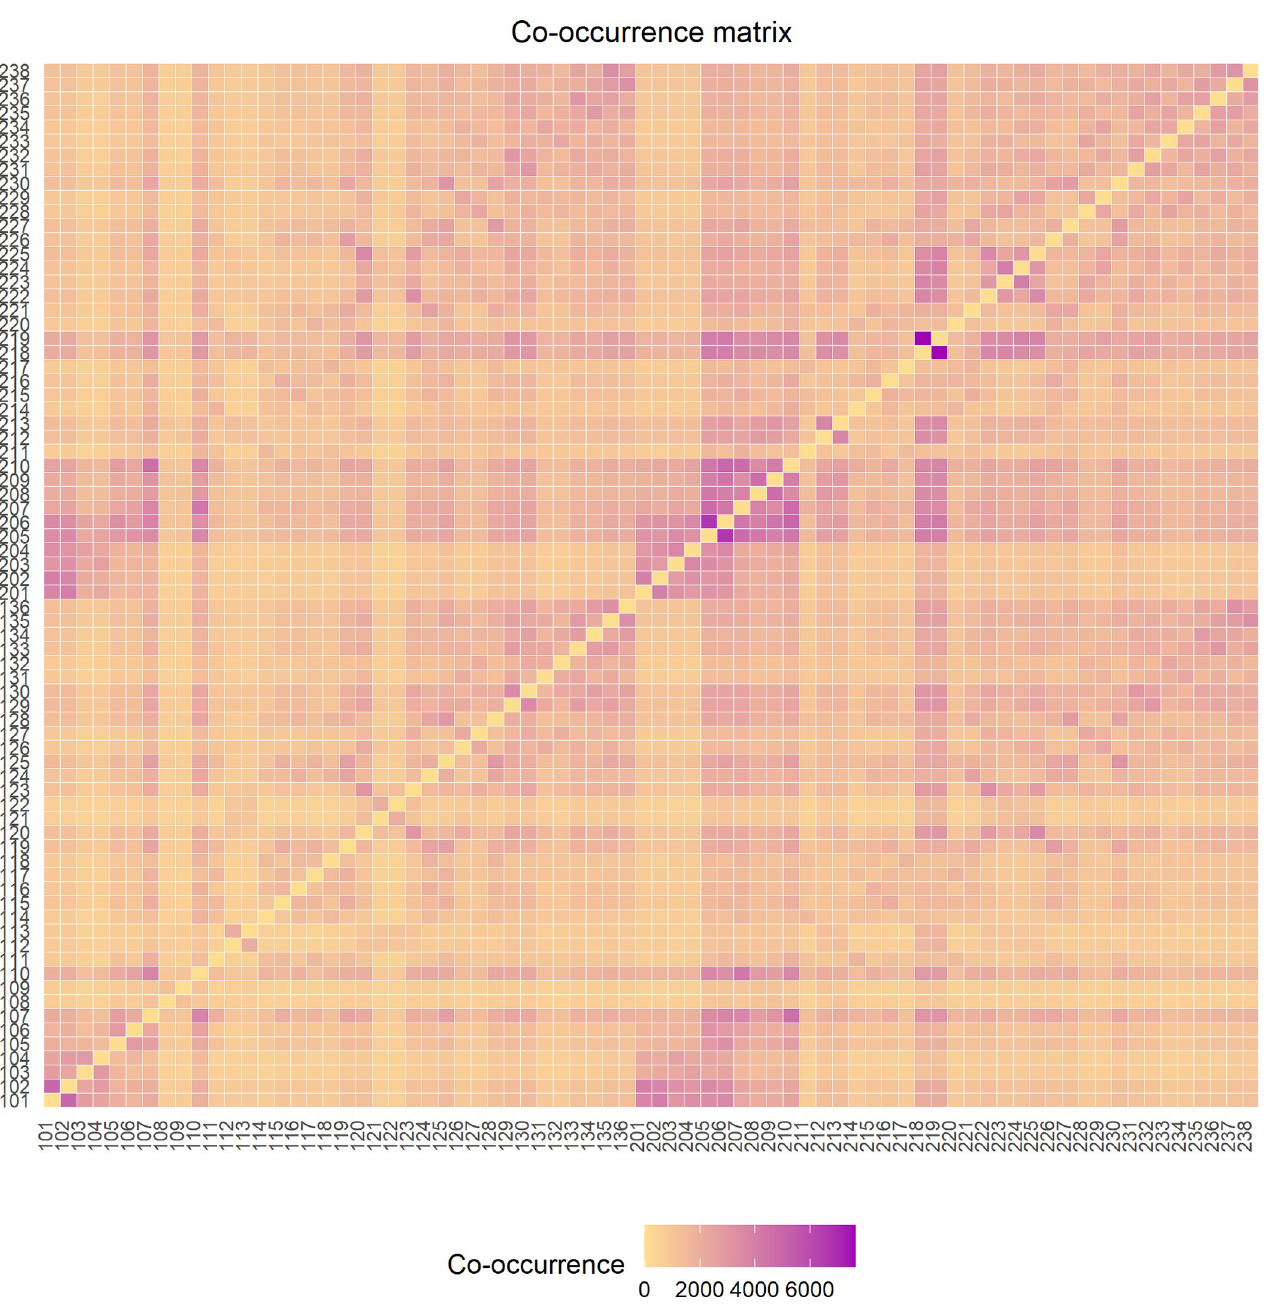
Fig 7. A co-occurrence heatmap illustrating the number of times each CBM area is endorsed concurrently with every other area. Cells are colored according to the number of times that any two locations were endorsed together by a patient, with lighter hues indicating more common endorsement in the